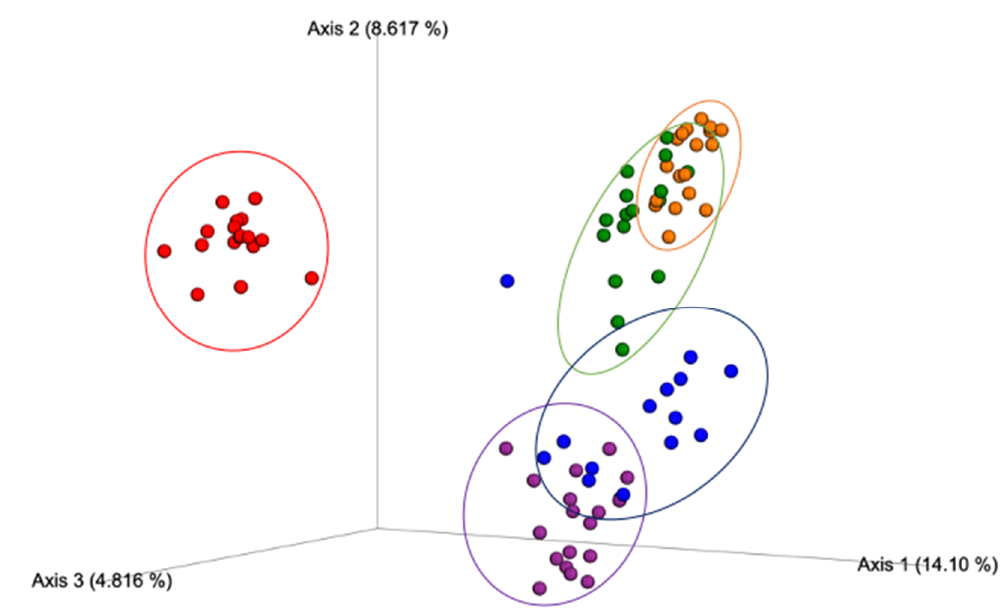
Figure 3. Beta-diversity PCoA plot of between-group distances using Jaccard distance matrix values. Treatment groups are as follows: control, red; high-fat, high-sugar diet (HFD), blue; HFD + genistein (Gen), purple; HFD + exercise (Exe), orange; HFD + Exe + Gen, green. Significant group differences ( p < 0.05) after Benjamini–Hochberg correction for multiple comparisons were observed for all pairwise treatment comparisons.